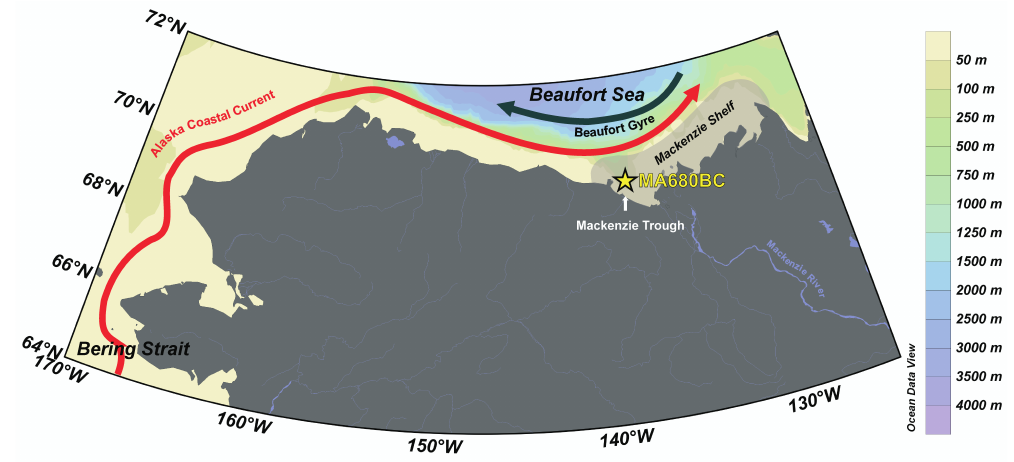
Fig. 1. Location map of core MA680BC and oceanic circulation in the study area. The black arrow represents the clockwise Beaufort Gyre, the red arrow indicates the Alaska Coastal Current and the grey area represents the Mackenzie River